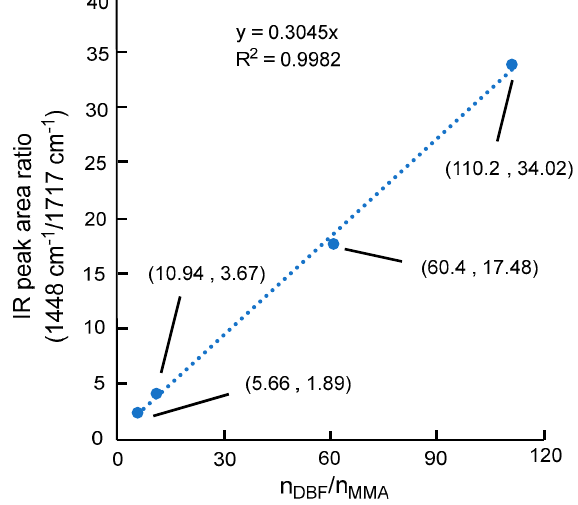
Figure A2. Linear function approximation of the data in Figure 1A through least squares regression.